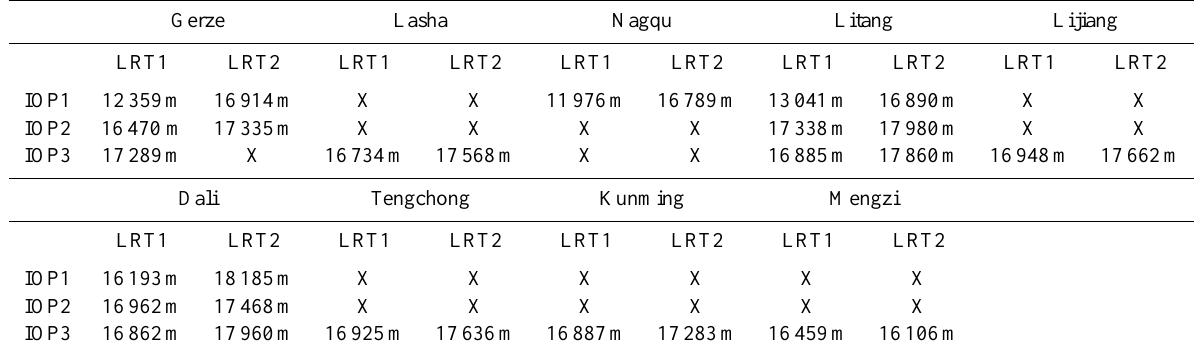
Table 3. Average height of LRT during the three observation periods.